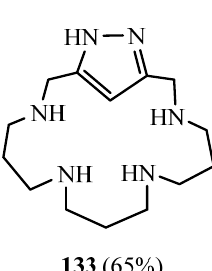
Figure 35. The structure of 1H-pyrazole cyclophane 133. (Reprinted with permission from ref. [56]. Copyright 2013 American Chemical Societ).